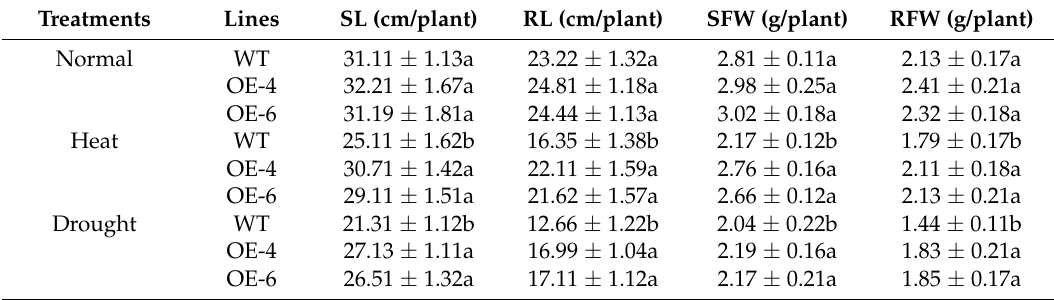
Table 1. Growth and biomass of the wild type and AtWRKY30 -overexpressing wheat plants grown under normal, heat, and drought stress